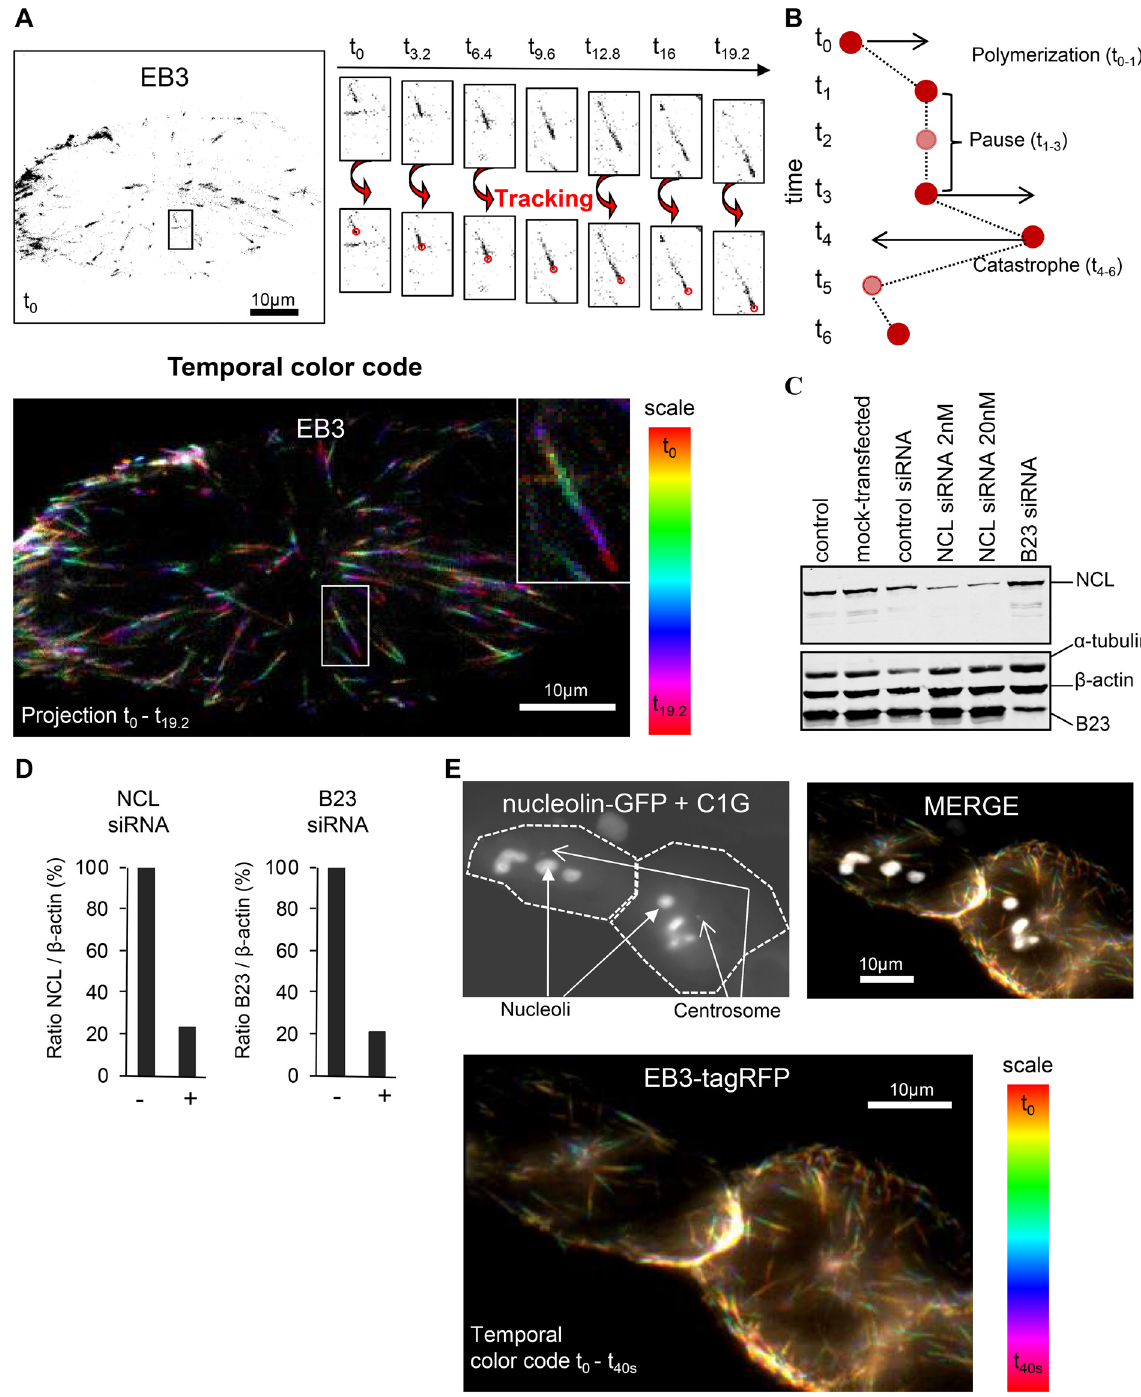
Fig 1. Microtubule dynamics analysis using the EB3-tagRFP plus-end tracking protein. (A) Still frames from time-lapse experiments show EB3-tagRFP signals. Upper left image represents EB3-tagRFP signal at t = 0s. On the right of the image, enlarged images of an EB3-tagRFP comet evolution (displayed on the full size image) are shown (upper enlarged panels from t = 0s to t = 19.2s). The plusTipTracker software package detects and tracks all the microtubule growing ends as exemplified on the enlarged images (lower enlarged panels). Lower image represents a temporal color code image of the EB3-tagRFP signal evolution from t = 0s to t = 19.2s. The color code scale is presented on the right. Scale bars represent 10 μ m. (B) Schematic representation of EB3-tagRFP tracking using the plusTipTracker software. Microtubule growing ends are schematized with the red circles.